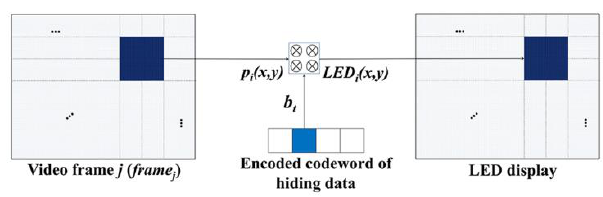
Figure 2. The LED-DCC point clustering